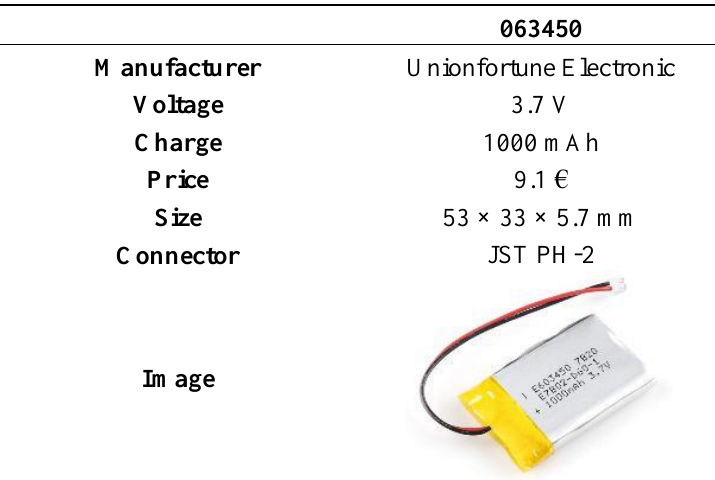
Table 7. Technical characteristics of the battery used.